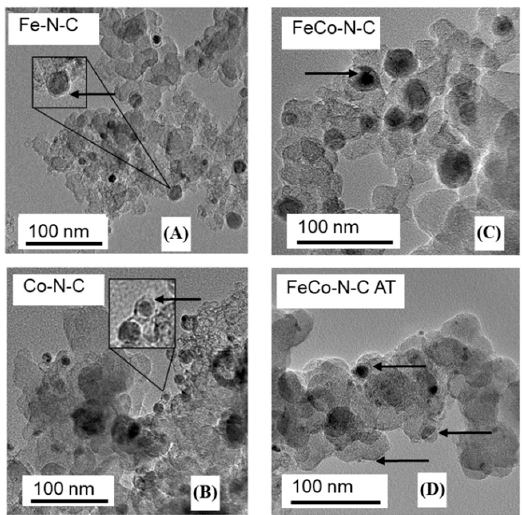
Figure 2. Transmission Electron Microscopy images of ( A ) Fe ‐ N ‐ C and ( B ) Co ‐ N ‐ C, ( C ) FeCo ‐ N ‐ C, and ( D ) FeCo ‐ N ‐ C AT showing that carbon ‐ encapsulated Fe and/or Co nanoparticles are also formed during the synthesis. The arrows indicated the graphitic carbon layers. AT refers to the acid treated sample. Table 1. The average percentage of elements investigated by EDX for the FeCo ‐ N ‐ C (as prepared) and Fe ‐ Co ‐ N ‐ C AT (acid treated) samples.